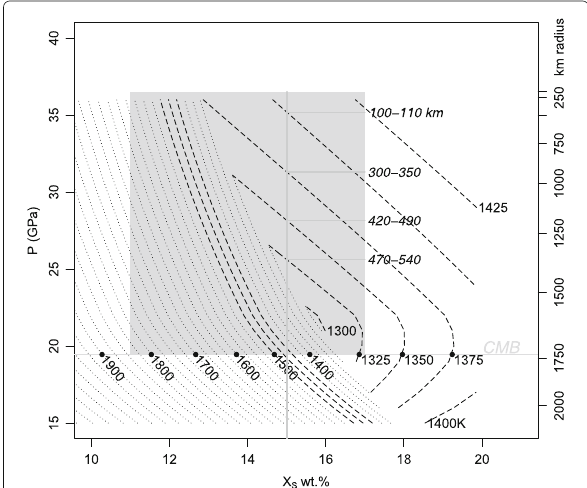
Fig. 5 Crystallization process of Mars’ core. Contours show pressure (left scale) and radius (right scale) where crystallization takes place along an adiabat extending from the CMB (horizontal gray line, labeled with T CMB ). Dotted lines show Fe crystallization conditions, whereas dashed lines show Fe 3 − x S 2 crystallization conditions. Gray box shows pressure/radius range of the core, and the anticipated compositional range of the core; range of radii of solid inner core crystallized from the liquid of 15 wt% S (vertical line) indicated by italic labels within the box. The dashed adiabatic temperature contours show that the core will grow rapidly with small changes in CMB temperature. The dotted Fe crystallization contours show that an iron ‘snow’ will form at the top of the core at temperatures below ∼ 1575 K. The range of inner core radii arises from alternative compositions of the solid core: Fe 3 S 2 or Fe 3 S